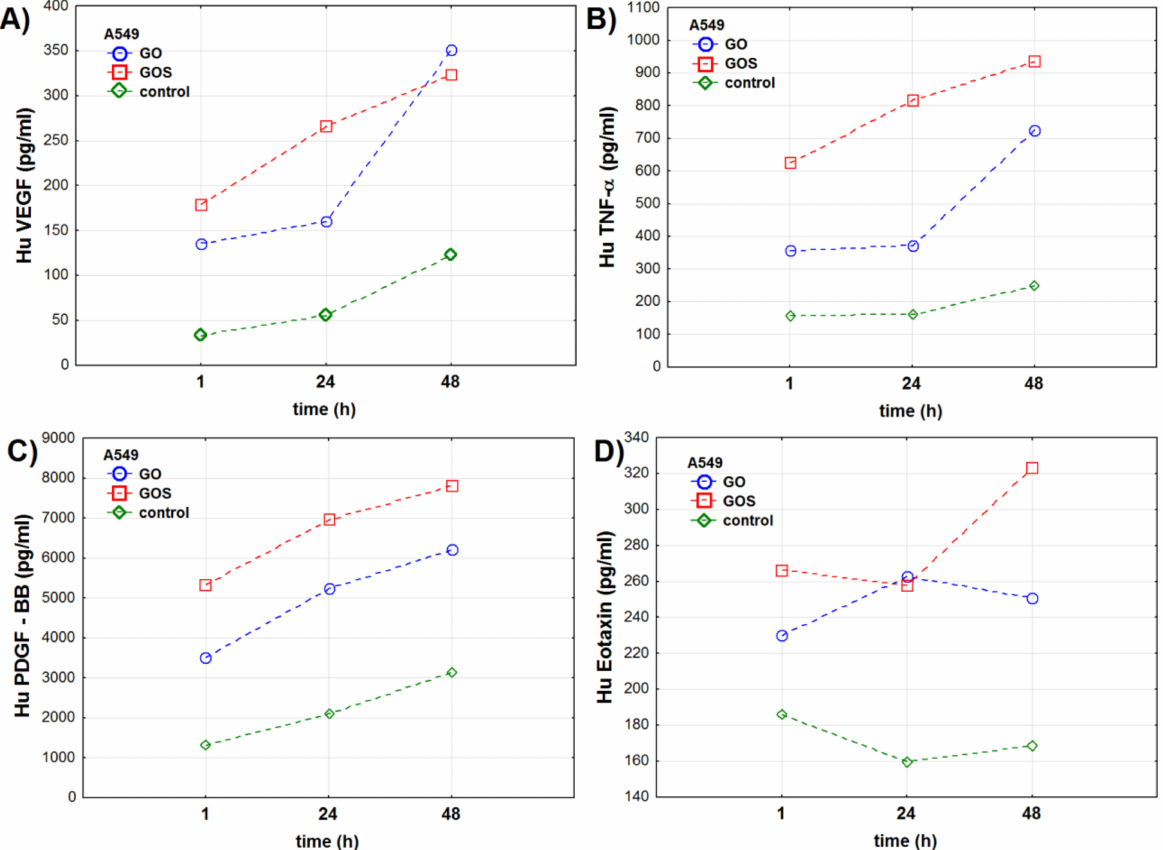
Figure 4. Cytokines’ concentration (pg/mL) in the A549 (adenocarcinomic human alveolar basal epithelial cells) cell line measured 1, 24, and 48 h after exposure to ultrapure (GO) or manganese ions-contaminated graphene oxide (GOS): ( A ) vascular endothelial growing factor (VEGF), ( B ) tumor necrosis factor-alpha (TNF- α ), ( C ) platelet-derived growth factor-BB (PDGF-BB), ( D ) eotaxin. The markers present mean value of the analyzed